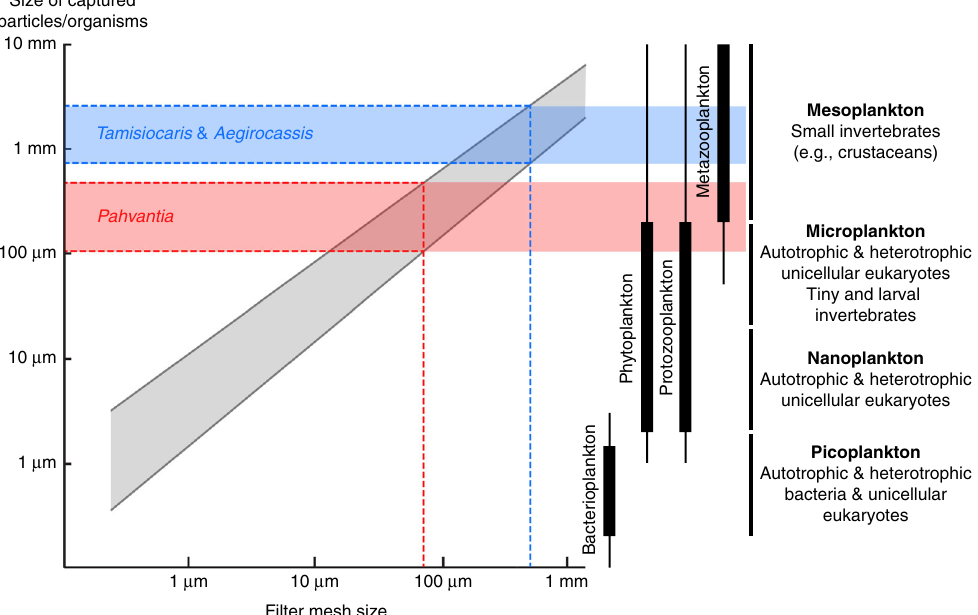
Fig. 4 Size of the particles captured by suspension-feeding radiodonts. With a mesh size of 70 µ m (red dashed line), P . hastata might have fed on microplankton, including phytoplankton. The mesh size was closed to 500 µ m (blue dashed line) in both Aegirocassis and Tamisiocaris , which therefore likely grazed on mesoplankton. Grey area depicts prey-size variation for a given mesh size in modern suspension feeders. Diagram on the left is modi fi ed after ref. 18 . Size distribution of main plankton types (right) is derived from ref. 63